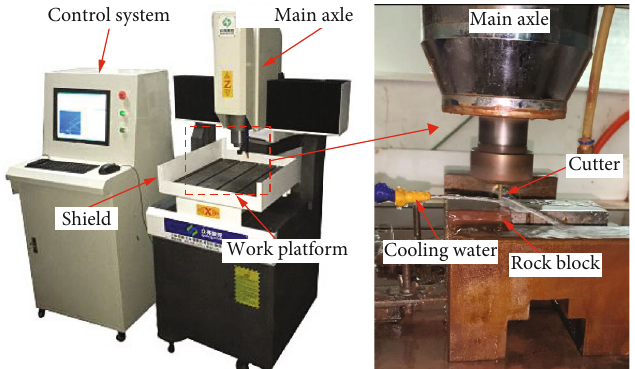
Figure 2: Engraving machine for manufacturing joint